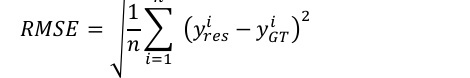
Figure 8. Scene (common room) from the V203 sequence (difficult).